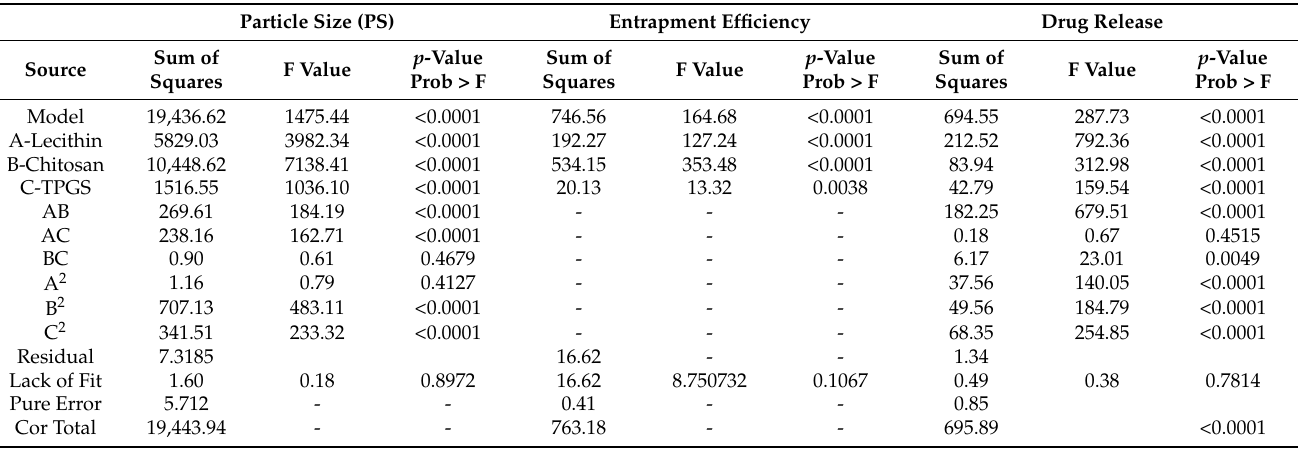
Table 2. ANOVA of best fit model of independent variables (PS -Y 1 , encapsulation efficiency -Y 2 , drug release -Y 3 ).